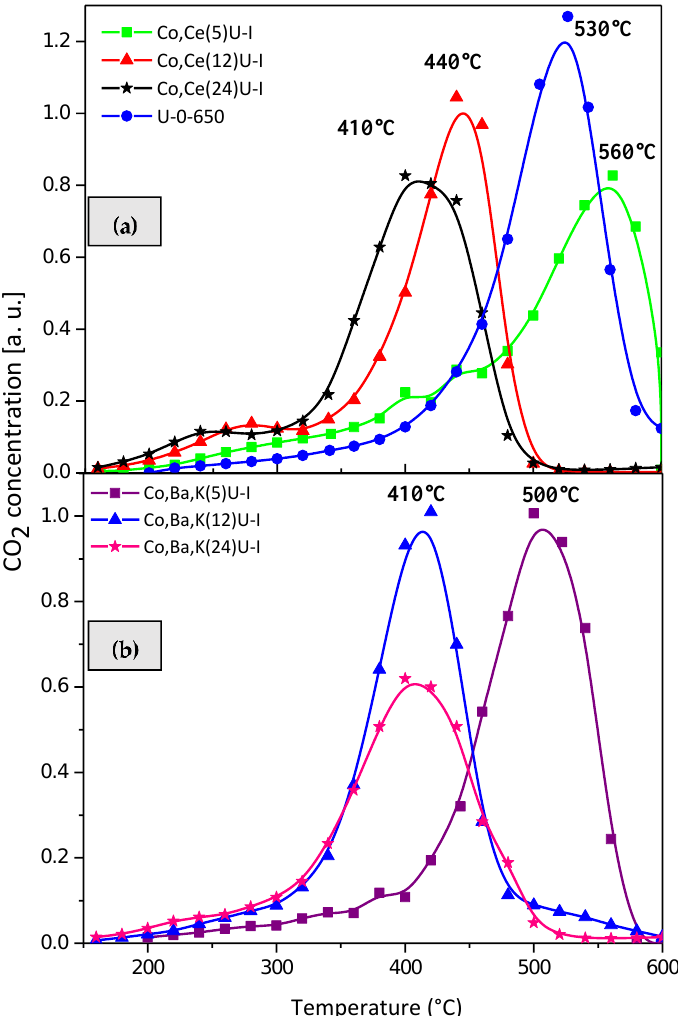
Figure 9. Effect on the catalytic activity for diesel soot combustion of the catalyst content in ceramic papers with ulexite containing: ( a ) Co,Ce and ( b ) Co,Ba,K. In order to analyze the cause of the improvement of the catalytic activity with the increase in the amount of active phase, X-ray diffraction was performed on the samples with 5 and 12% of catalyst incorporated. As can be seen in Figure 10, for both Co,Ce(12)U- I and Co,Ba,K(12)U-I, increasing the amount of active phase results in more intense peaks in the diffraction patterns of the samples, indicating an increase in the crystallinity of the